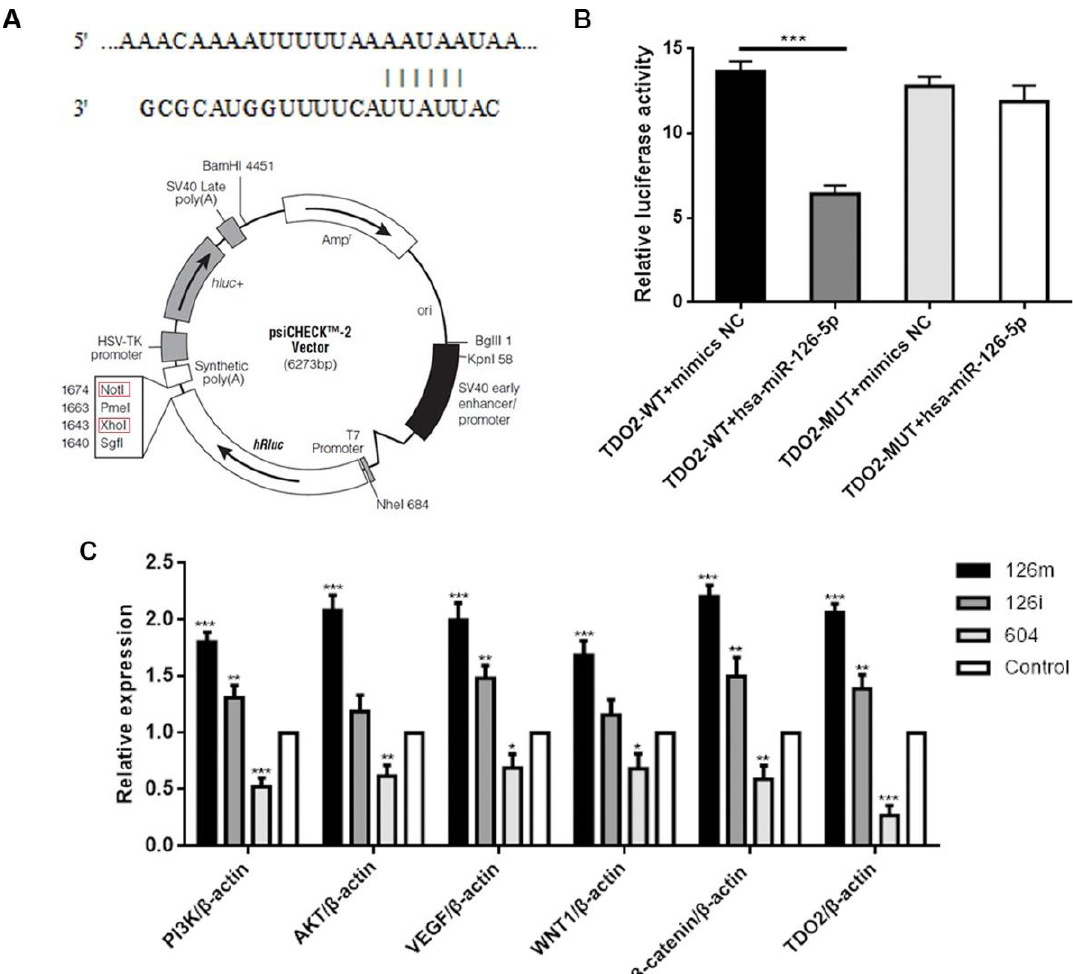
Figure 2. MiR-126-5p binds to TDO2 and influences the expression of the related signaling pathway proteins. ( A ) Atlas of plasmid (psiCHECK-2 Vector) was used for dual luciferase assays. ( B ) After transfection with miR-NC or miR-126-5p in HEK293T cells, the relative luciferase activity of mutant or wild- type TDO2 3′ -UTR was detected. ( C ) Effect of 126m (miR-126-5p mimics), 126i (miR-126-5p inhibitors), 604 (siRNA-TDO2) on signaling pathways and TDO2 expression. All experiments were